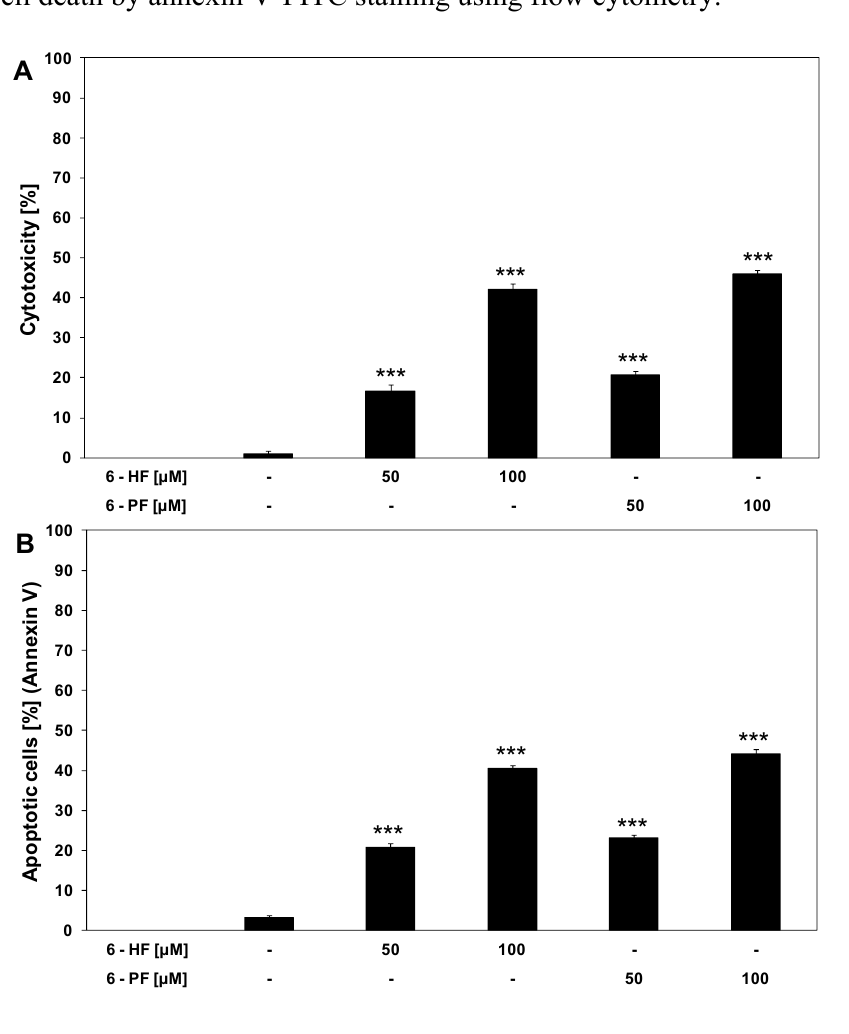
Figure 2. Cytotoxic and apoptotic activities of synthetic flavanones in HeLa cancer cells. The cancer cells were incubated for 48 h with 6-HF or 6-PF at the concentrations of 50 μ M and 100 μ M. The values represent mean ± SD of three independent experiments performed in quadruplicate ( p < 0.05) ( *** p < 0.001 compared with control). ( A ) Cytotoxic activity of flavanones in HeLa cells. The percentage of cell death was measured by MTT cytotoxicity assay; ( B ) Apoptotic activity of flavanones in HeLa cells. Detection of apoptotic cell death by annexin V-FITC staining using flow